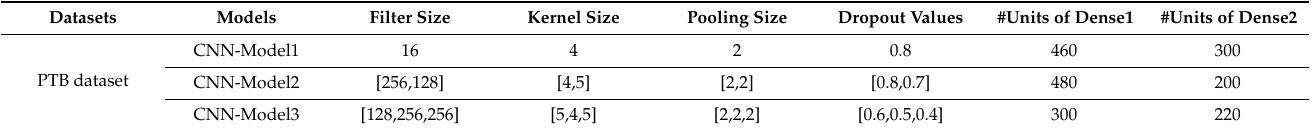
Table 6. The values of the parameters after applying the CNN models to the MIT-BIH and PTB